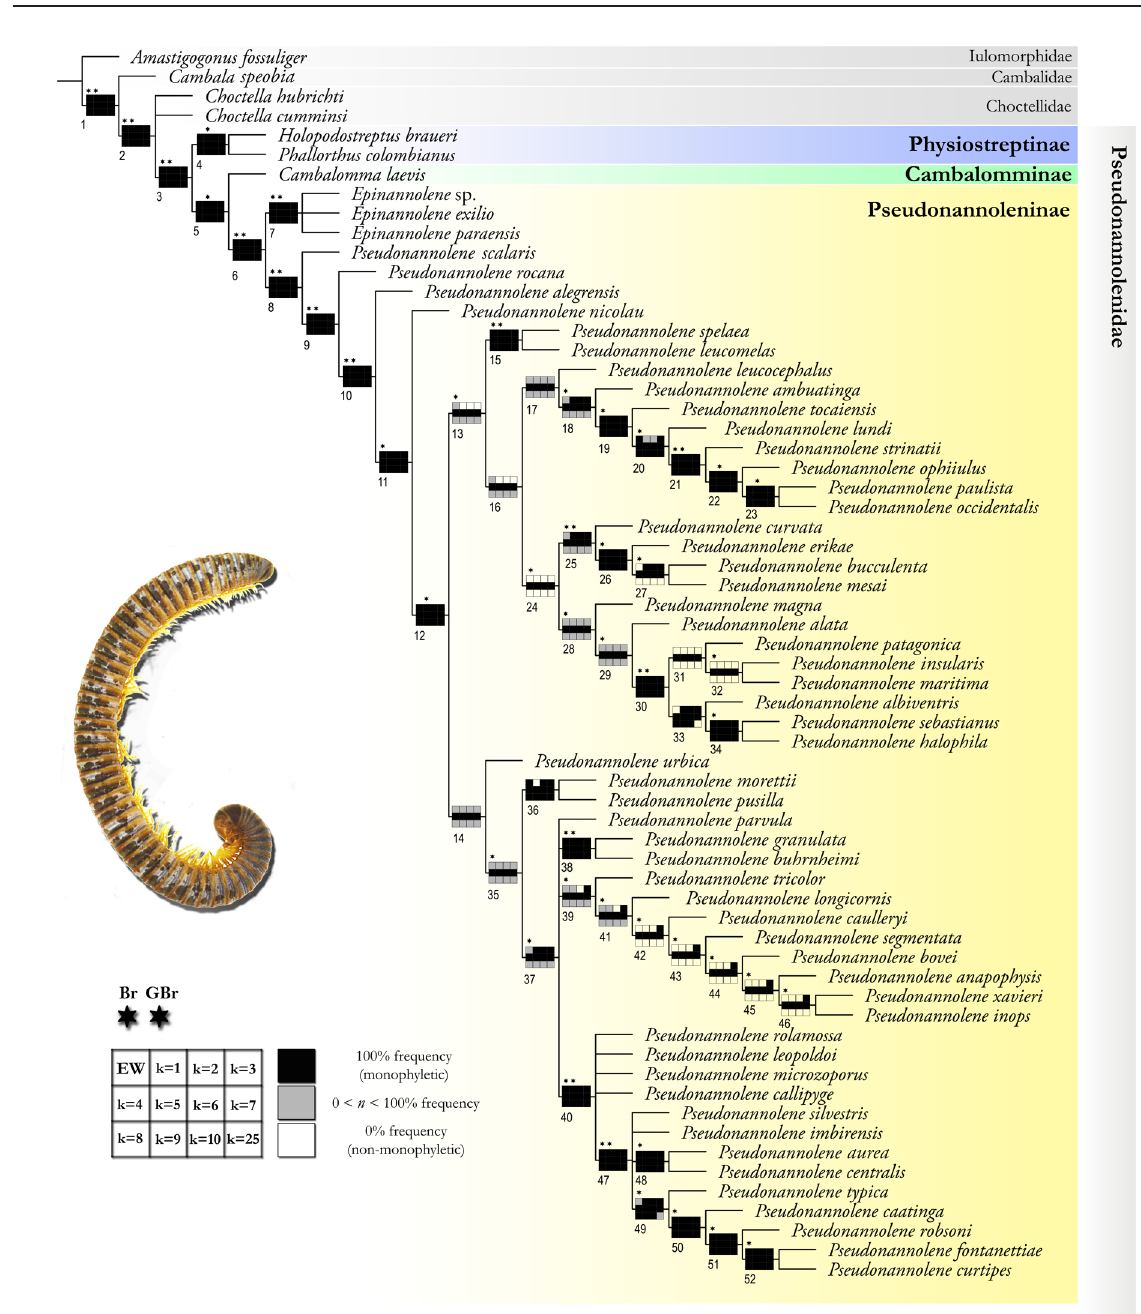
Fig. 4 . Strict consensus of 27 equally parsimonious trees under implied weighting ( k = 4–7). Clades with the sensitivity to different k values are represented by the frequency on the Navajo–rugs. Clades with asterisk have values of Bremer relative [Br] above 50 and Goodman-Bremer [GBr] of